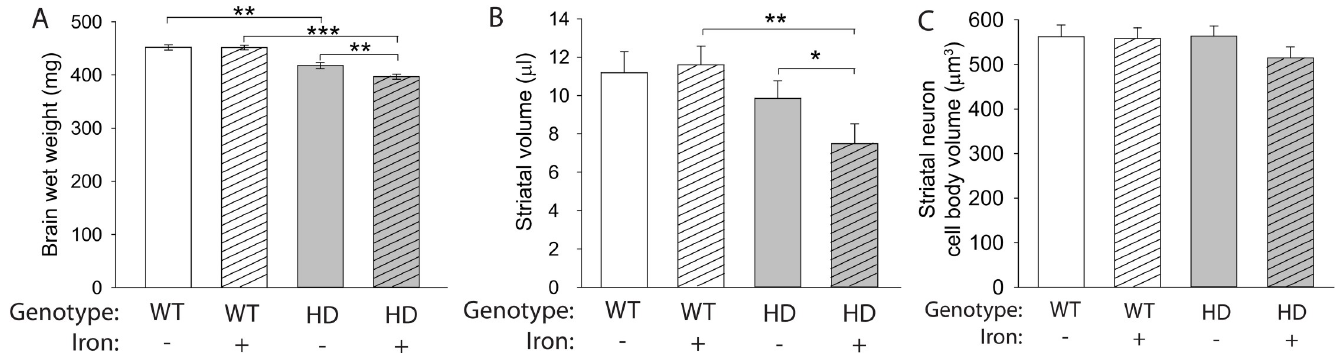
Fig 3. Neonatal iron supplementation exacerbates HD in the N171-82Q mouse model. Mouse pups were administered neonatal iron from postnatal days 10–17 then were sacrificed at 14 weeks of age. A . Total brain wet weight decreased in HD mice at 14 weeks of age. n = 15 WT control, 19 WT NIS, 13 HD control, 17 HD NIS. B . Striatal volume measured using the Cavalieri method was decreased in iron-supplemented HD mice compared with both control HD mice and iron-supplemented WT mice. C . Cell body volume of striatal neurons was not significantly different among groups. Data are shown as the mean ± SE. �� p < 0.01, ��� p < 0.001. B, C. n = 10 WT control, 11 WT NIS, 12 HD control, 11 HD